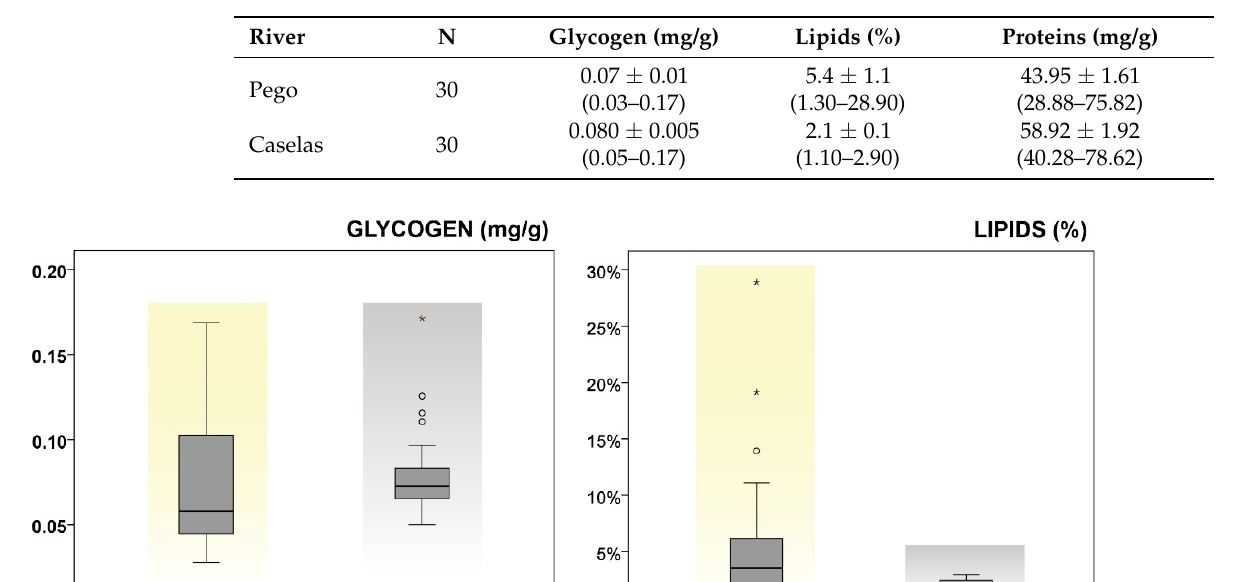
Table 5. Average ± standard error (range) of glycogen (mg/g), protein (mg/g) and lipids (%) concentration (60 specimens of G. lozanoi ) of the two analyzed populations.